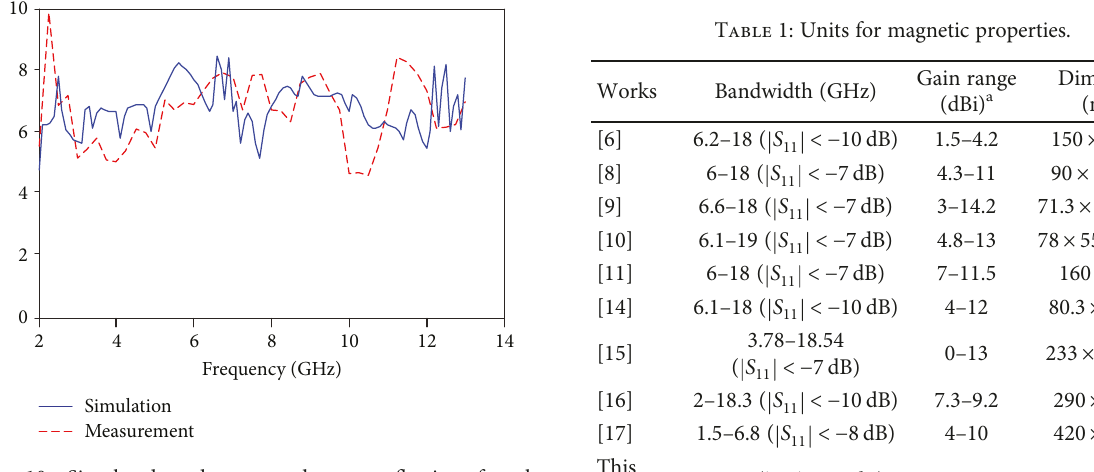
Figure 10: Simulated and measured port re fl ection for the assembled antenna.